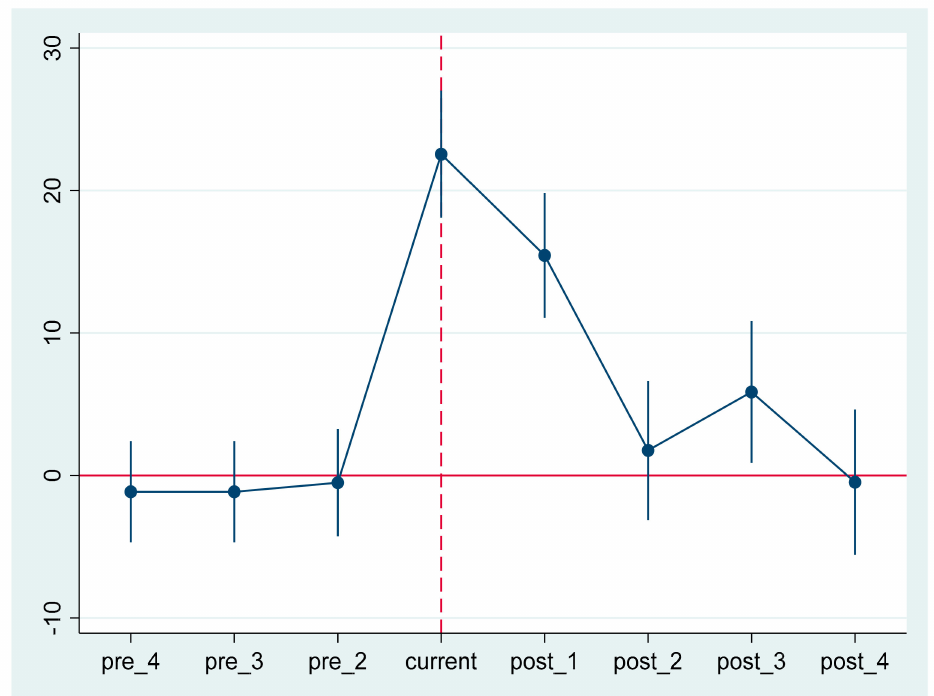
Figure 2. Dynamic effect of the DID